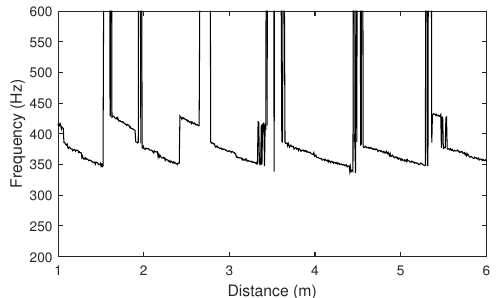
Figure 8. Resonant frequency approximations by the position of maximum energy in the spectra of the simulated feedback signals. Distance is simulated as the length of a silence appended to the beginning of the impulse